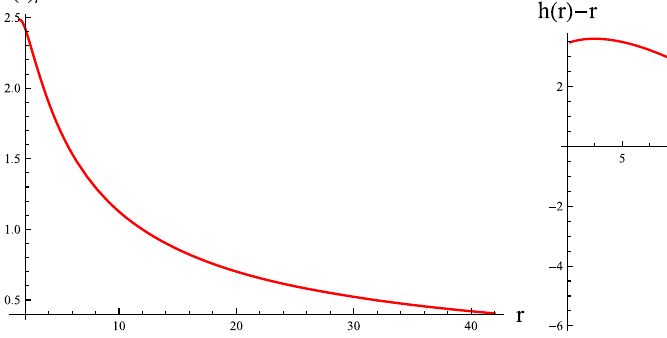
Fig. 10 Variation of the shape function versus r